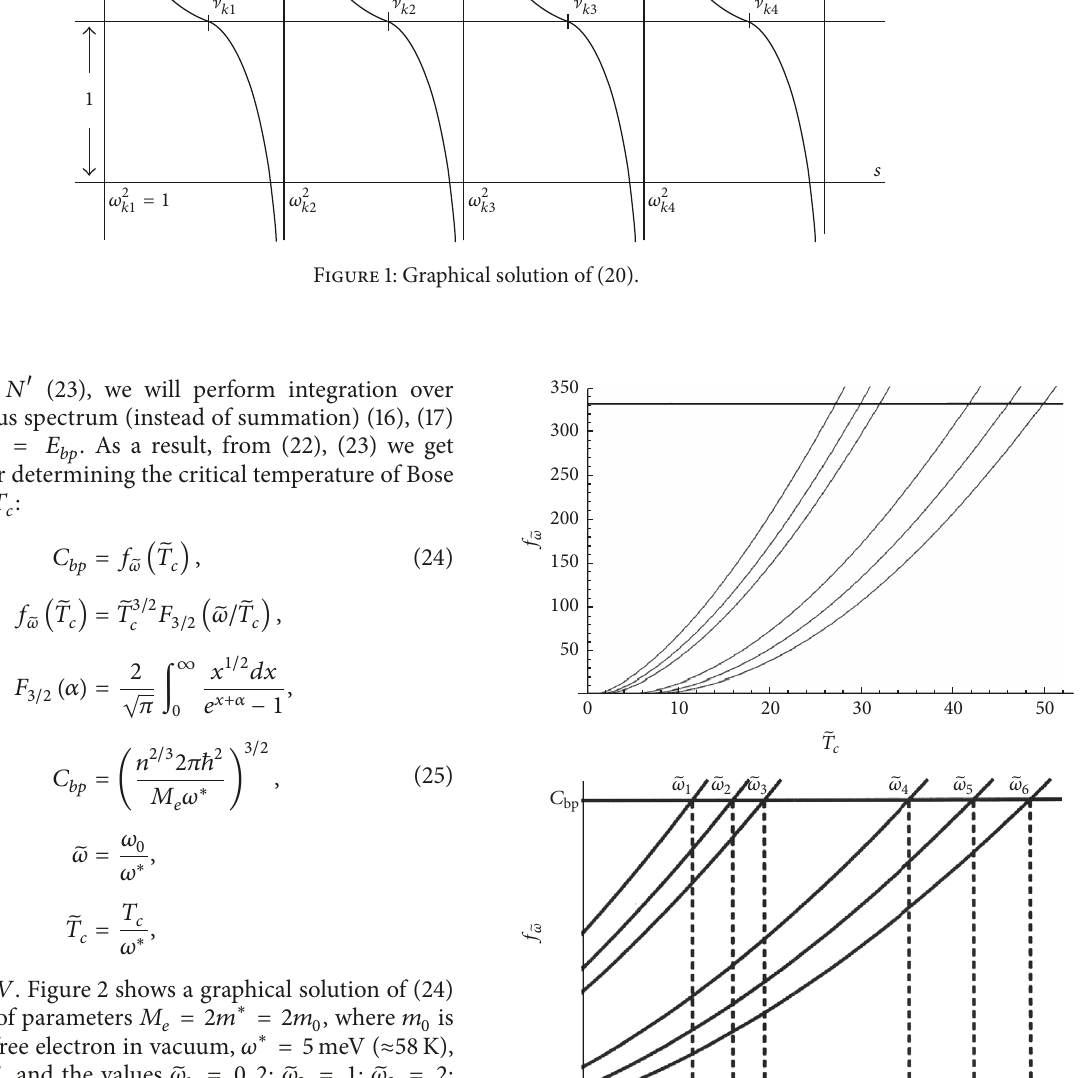
= 30 ; ̃𝑇 = 32 ; 𝑐 2 𝑐 3